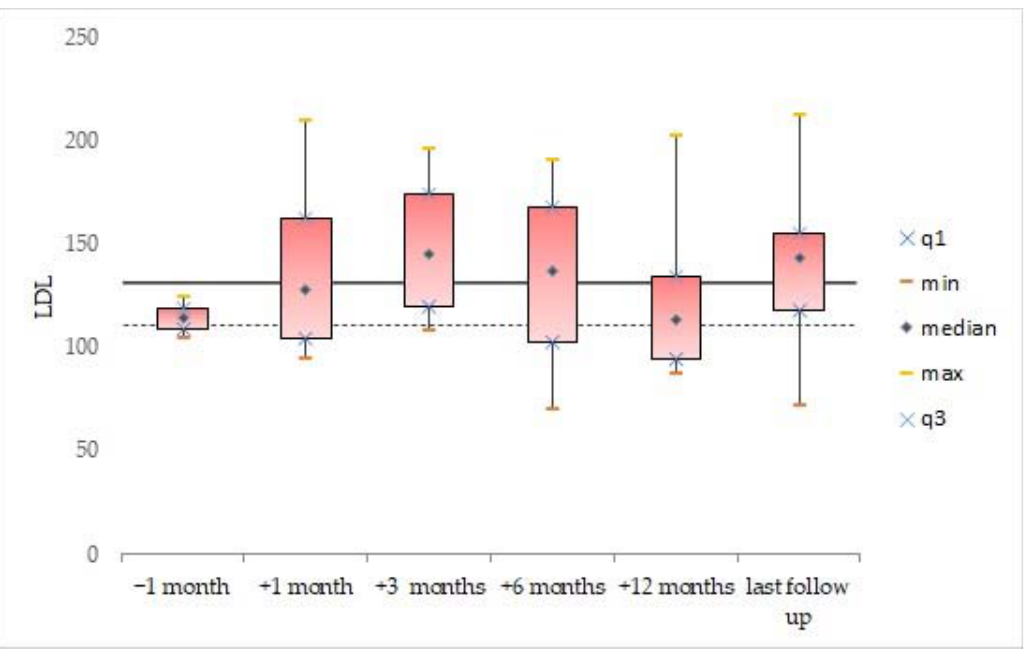
Figure 4. LDL levels before and during vemurafenib. The dashed line indicates the acceptable upper limit, the double line indicates the borderline ‐ high limit according to the NCEP Expert Panel on Cholesterol Levels in Children.